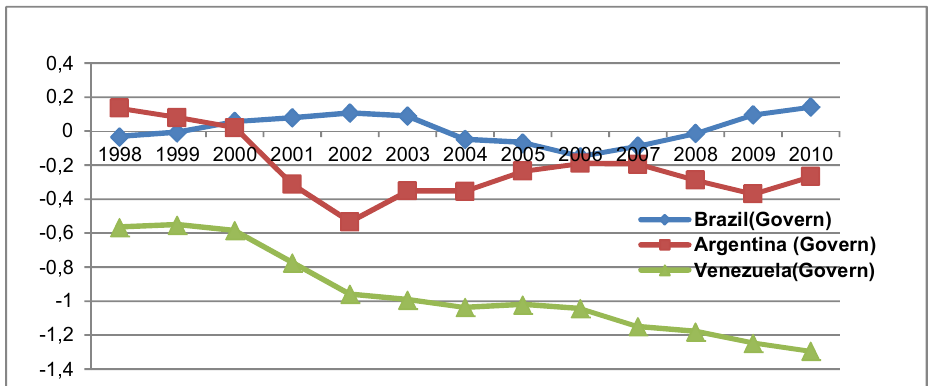
Figure 10: Trends of Overall Governance